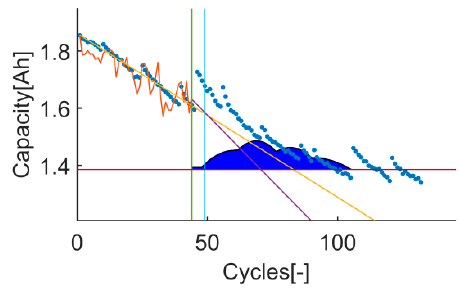
Figure 21. Time-instant figure of test 2 on t 38 .